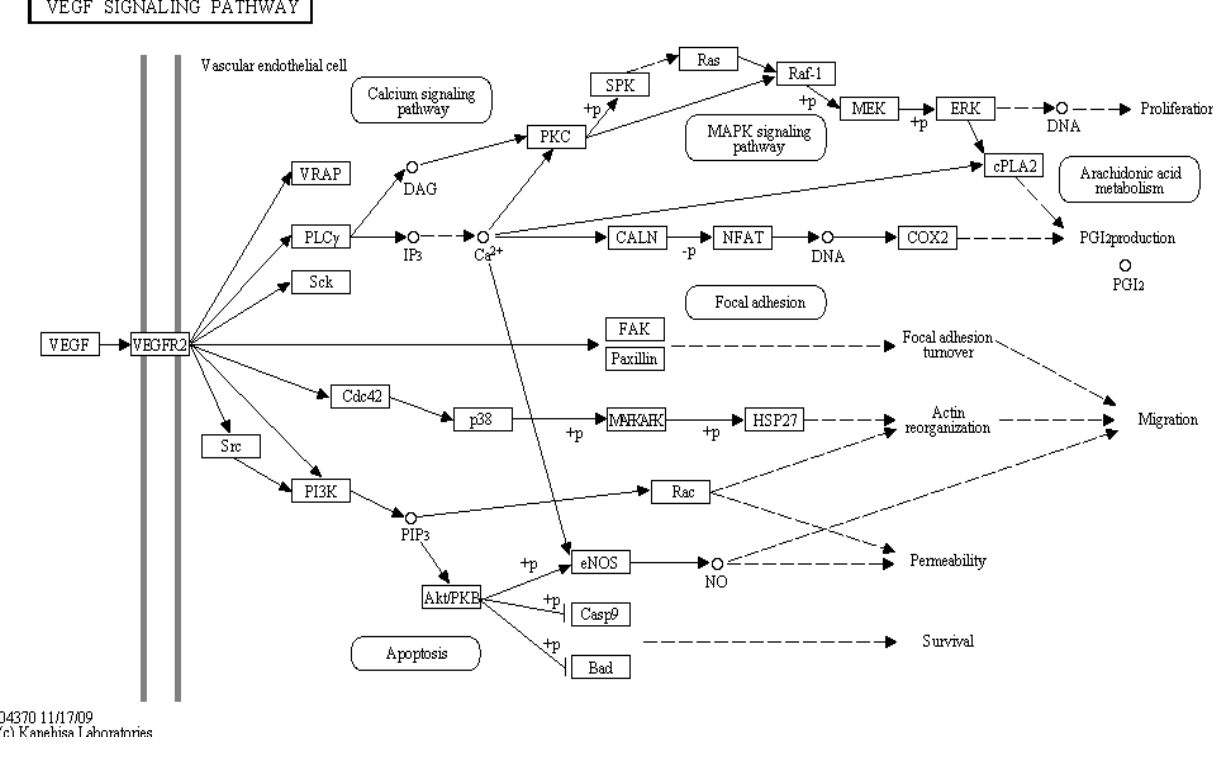
Figure 2. A map of the VEGF signaling pathway (as an example of an important target in cancer therapy) obtained from KEGG is shown [41]. The gene expression studies are